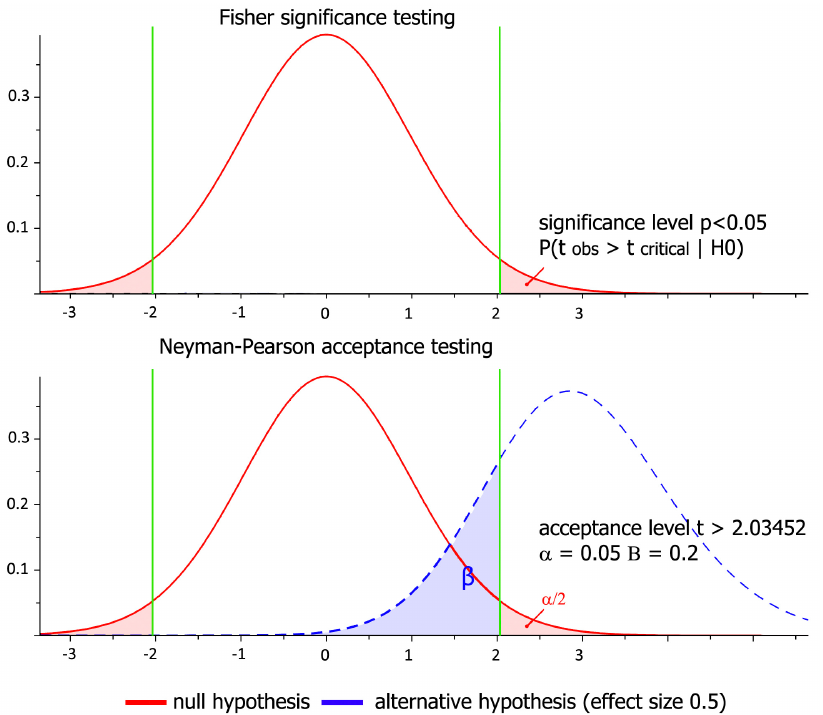
Figure 1. Illustration of the difference between the Fisher and Neyman-Pearson procedures. The figure was prepared with G-power for a two-sided one-sample t-test, an effect size of 0.5. In Fisher’s procedure, only the null-hypothesis is posed, and the observed p-value is compared to an a priori level of significance. If the observed p-value is below this level (here p=0.05), one rejects H0. In Neyman-Pearson’s procedure, the null and alternative hypotheses are specified along with an a priori level of acceptance (here alpha 0.05 beta 0.8). If the observed statistical value t value is outside the critical region (here [- ∞ -2.57] [2.57+ ∞ ]), one rejects